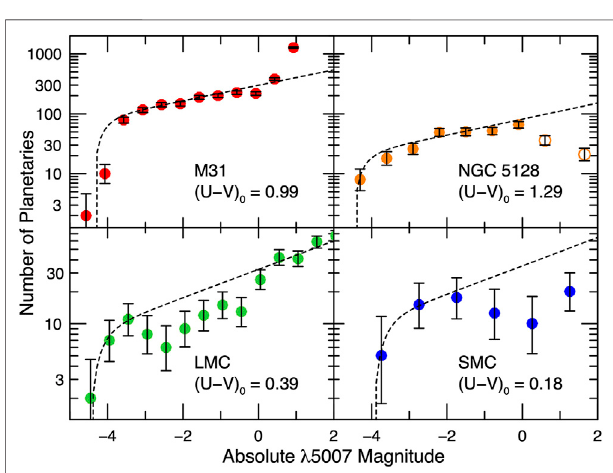
FIGURE 2 | The [O III] planetary nebula luminosity functions of M31 (Bhattacharya et al., 2019), NGC 5128 (Ciardullo, 2010), the LMC (Reid and Parker,2010),and the SMC(Jacobyand De Marco, 2002).Thedashed curve showsthedistributionpredictedby Eq.3 .ThePNLFsofthefourgalaxies vary substantially, but all have a very sharp bright-end cutoff at M 5007 ~ − 4.5. (The cutoff is ~ 0 . 5 mag fainter in the SMC due to the galaxy ’ s low metallicity.) The survey of NGC 5128 is incomplete beyond M 5007 ~ 0 (open